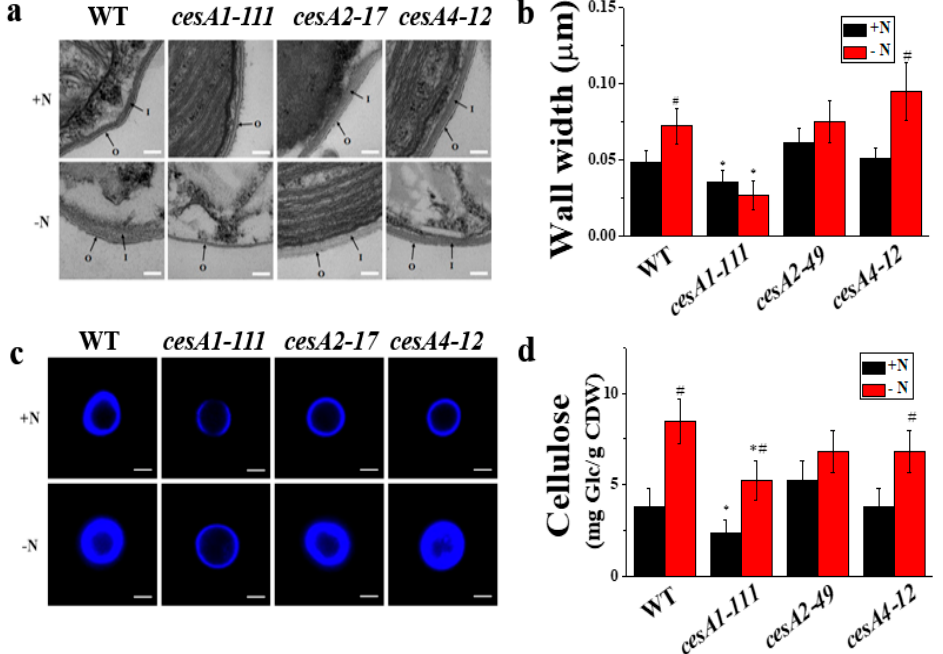
Figure 1. Transmission electron microscopy images of the cell wall ( a ), cell wall width ( b ), calcofluor white (CW) fluorescence staining ( c ), and cellulose content ( d ) of N. salina wild-type (WT) and cesA mutants grown under + N and –N conditions for 3 d. In (a), I and O represent the inner and outer cell wall layers, respectively. In ( b ), the cell wall of 200 + N or –N cells was measured in five di ff erent places. Each data point represents the mean ± SE of three biological replicates performed in triplicate. The symbols represent statistically significant di ff erences ( p ≤ 0.05) between mutants vs. wild-type (*), and between + N and -N cells (#), accordingly. Scale bars, 100 nm and 2 µ m, in (a) and (c), respectively.